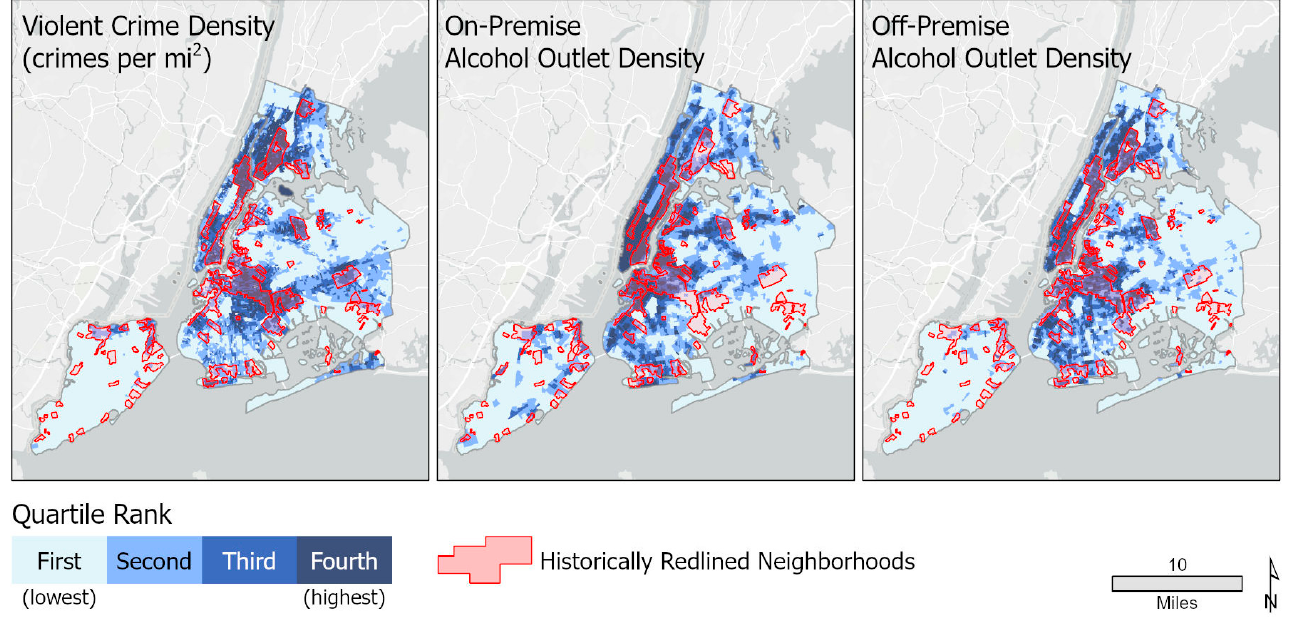
Figure 1. Distribution of violent crime density, on-, and off-premise alcohol outlet density/access score in redlined and non-redlined neighborhoods in New York City.